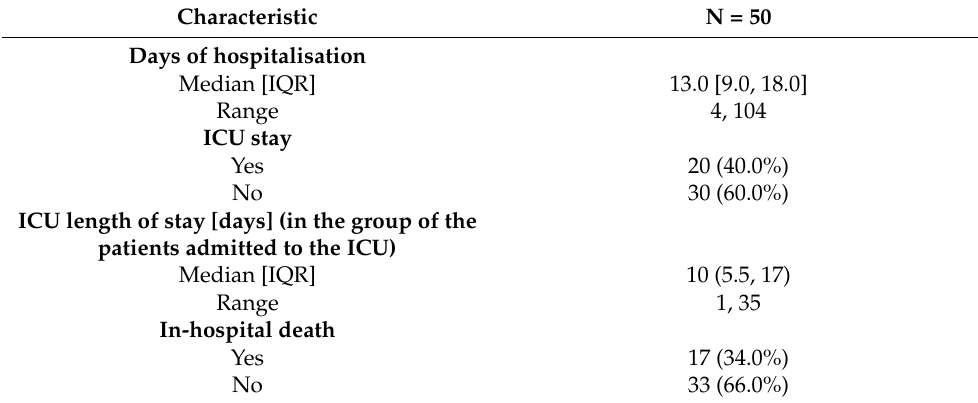
Table 3. Data on treatment